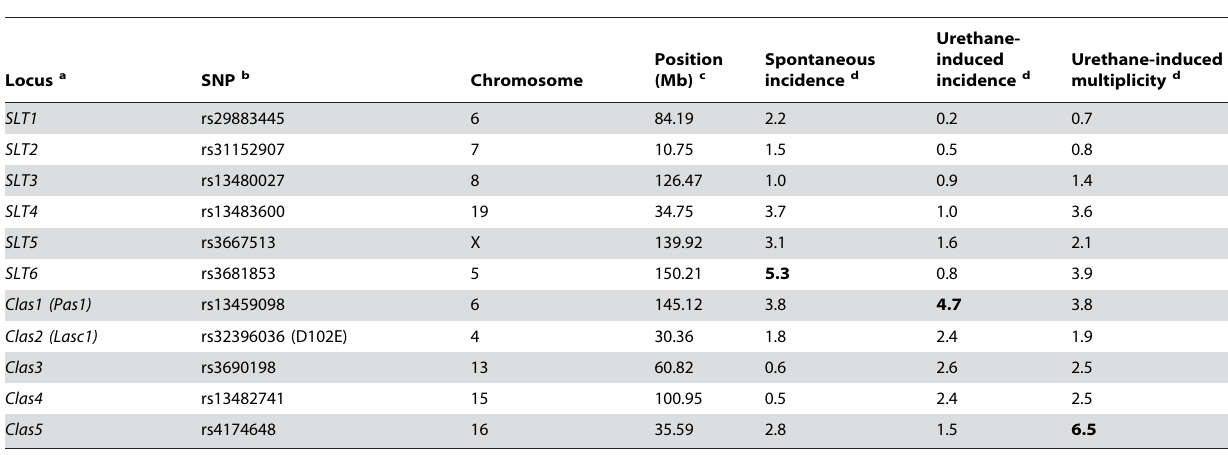
Table 3. Putative lung tumor modifier loci identified by previous genome-wide association studies or by the present study using the WTCHG SNP panel.